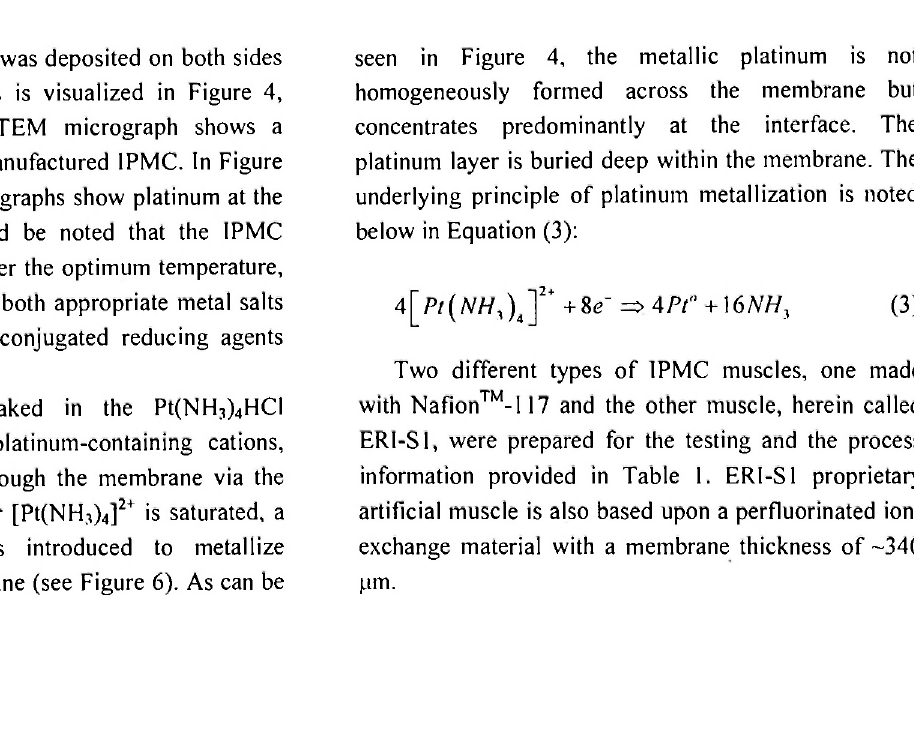
Fig. 3: Tensile testing results of Naflon™-l 17 (dry, H + form) and Teflon™ INSTRON tabletop 1011 was used. The size of sample is 10 χ 70 mm. The applied strain rate is 0.0012 (mm/mm)/sec. The thickness of Teflon was 5 mil (0.005 inch). The normal stress is plotted against the normal strain.